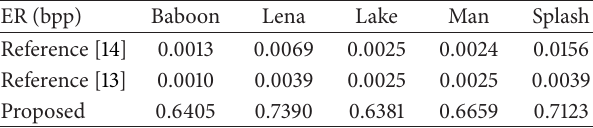
Table 5: Embedding rate comparison with existing